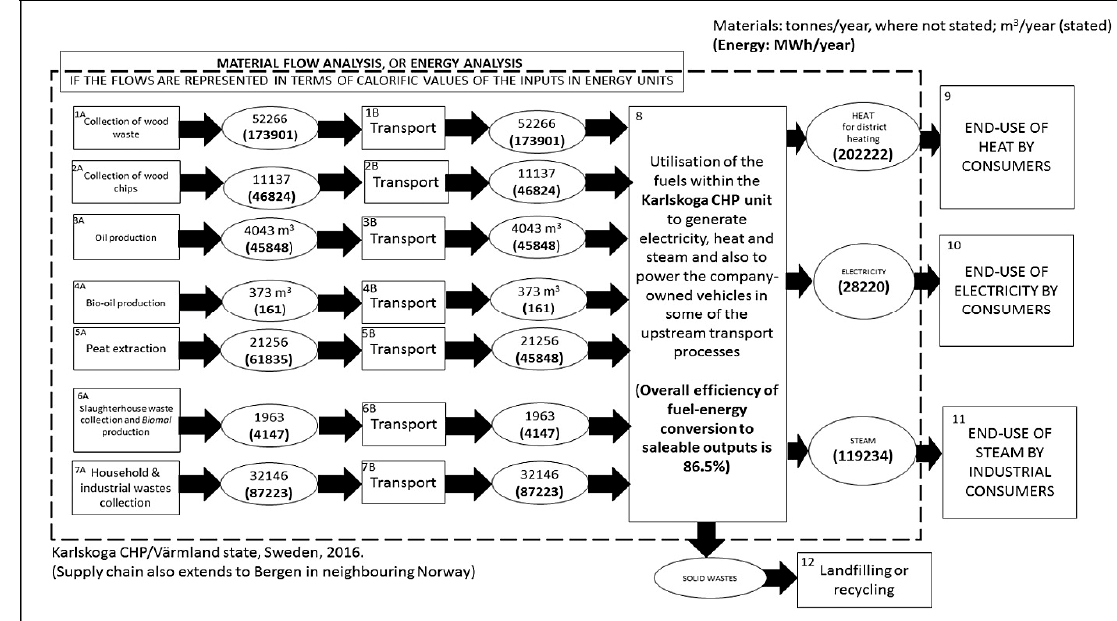
Figure 4. Material and energy flows of Karlskoga combined heat and power plant 2016 [57].